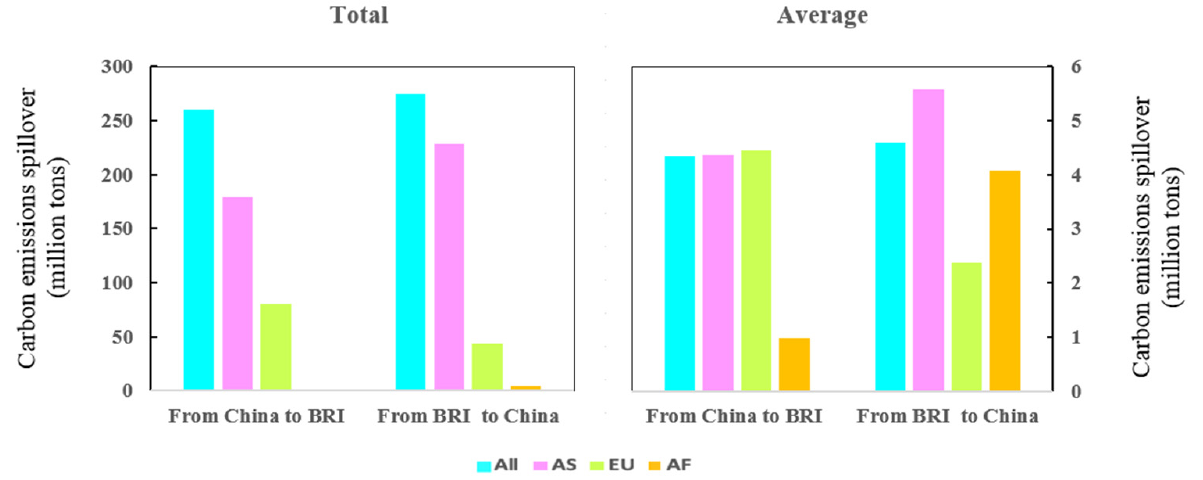
Figure 2. CSE between China and BRI countries.